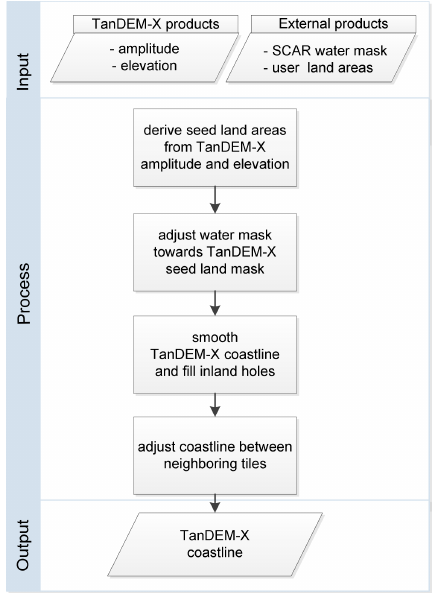
Figure 7. Workflow for (semi-)automatic TanDEM-X coastline de-